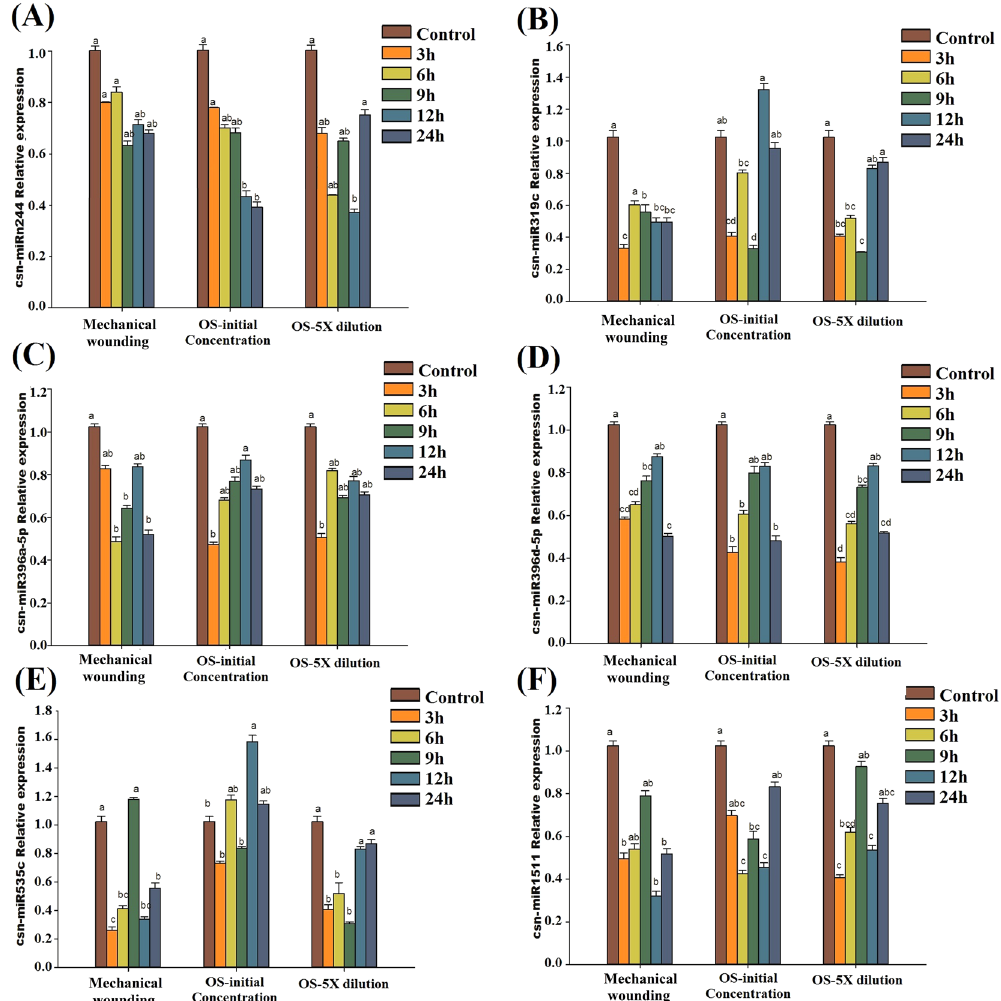
Figure 8. Relative expression levels of six miRNAs in C . sinensis leaves exposed to mechanical damage and E . oblique saliva (OS) at different time intervals by qRT-PCR: csnmiRn224 ( A ), csn-miR319c ( B ), csn-miR396a-5p ( C ), csn-miR396d-5p ( D ), csn-miR535c ( E ), and csn-miR1511 ( F ). The expression levels of miRNAs were normalized to that of U6. Relative expression was calculated using the 2 −ΔΔ CT method. Data represent the means ± SD values (n = 3) of three biological samples. Different letters above bars represent significant differences at P <